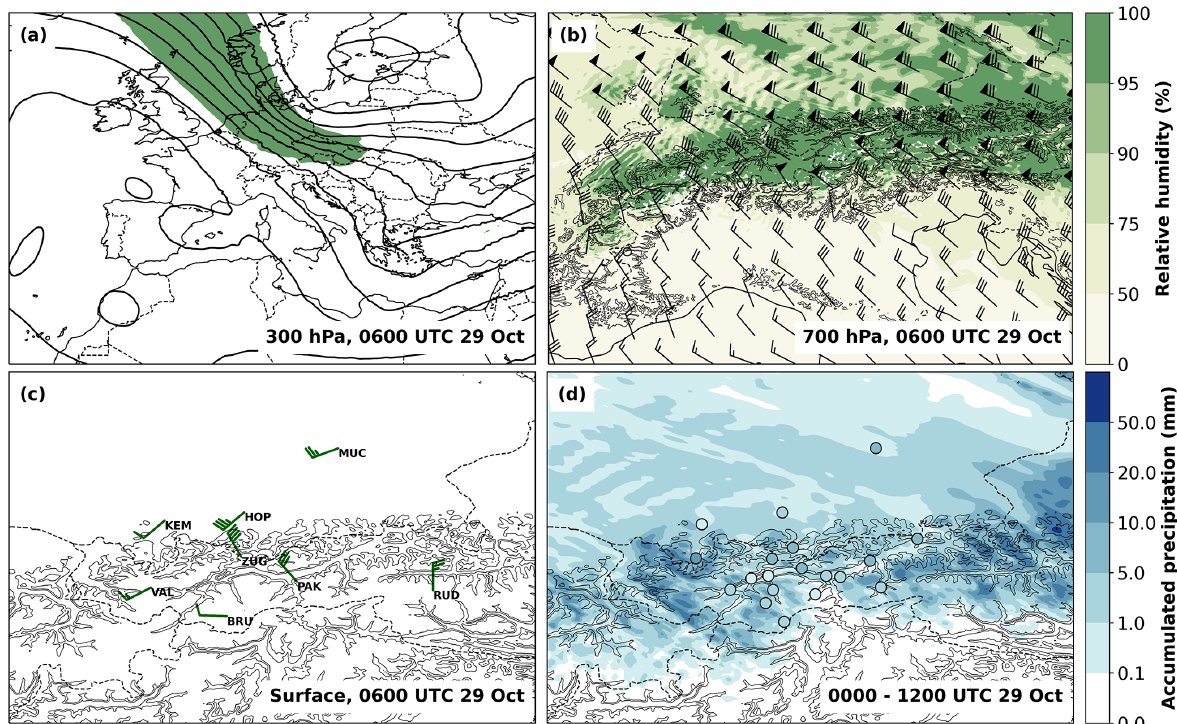
Figure 2. Synoptic situation on 29 October 2017. (a) ECMWF analysis of geopotential (black contour lines, spacing 1000m 2 s − 2 ) and wind speed (shading, wind speed greater than 50ms − 1 is shaded in green) at 300hPa at 06:00UTC. (b) WRF simulated fields of wind (barbs) and relative humidity (color contours) at 700hPa at 06:00UTC. (c) Observed winds (barbs) at 06:00UTC. Abbreviations indicate station names: Munich (MUC), Kempten (KEM), Hohenpeissenberg (HOP), Zugspitze (ZUG), Valluga (VAL), Brunnenkogel (BRU), Patscherkofel (PAK), and Rudolfshütte (RUD). (d) Precipitation accumulated between 00:00 and 12:00UTC in subdomain SD2 simulated by WRF (color contours) and observed (filled circles with the same color scale). National borders are as in Fig. 1, and model topography in (b) – (d) is indicated by black contour lines for the elevations of 1000 and 1500ma.m.s.l. Wind barbs in (b) and (c) indicate the wind speed (in kn): half barb, full barb, and triangle denote 2.5, 5, and 25ms − 1 .